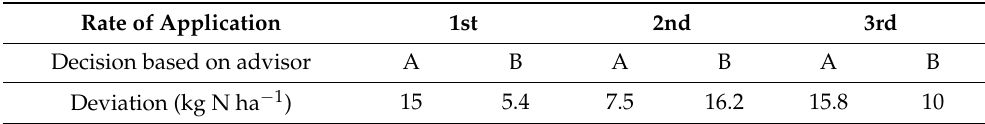
Table 3. Average absolute deviation of the DSS from the farmer’s or advisor’s opinion (tested on farms in the advisor’s own advisory area; adjusted for described exceptions).